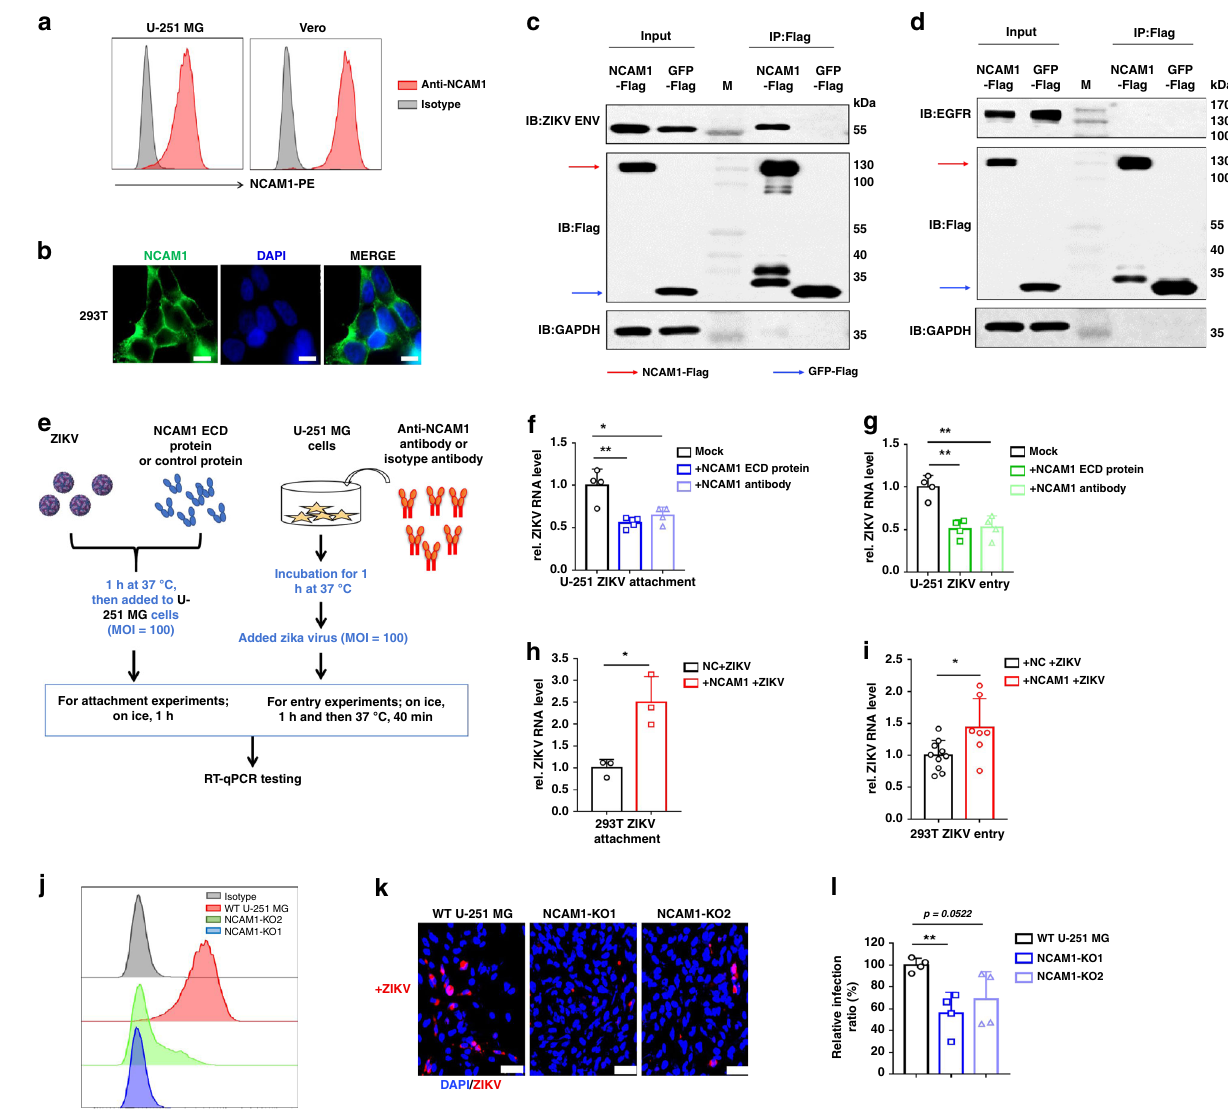
Fig. 4 Identi fi cation and validation of NCAM1 as a potential host receptor for ZIKV. a , b Flow cytometry ( a ) and immuno fl uorescence ( b ) analyses of NCAM1 expression in U-251 MG, Vero or 293T cells. 293T cells were transfected with NCAM1 for 48 h. The length of scale bars in ( b ) is 10 μ m. c , d Immunoblot (IB) and immunoprecipitation (IP) of lysates of ZIKV ENV ( c ) or EGFR ( d ) and Flag-NCAM1 or Flag-GFP overexpressed 293T cells. e Schematic representation of the viral binding and entry assays. f , g NCAM1 ECD protein and anti-NCAM1 antibody inhibit ZIKV attachment to U-251 MG cells ( f ). * P = 0.0168; ** P = 0.0047. NCAM1 ECD protein and anti-NCAM1 antibody inhibit ZIKV internalized to U-251 MG cells ( g ). Data from